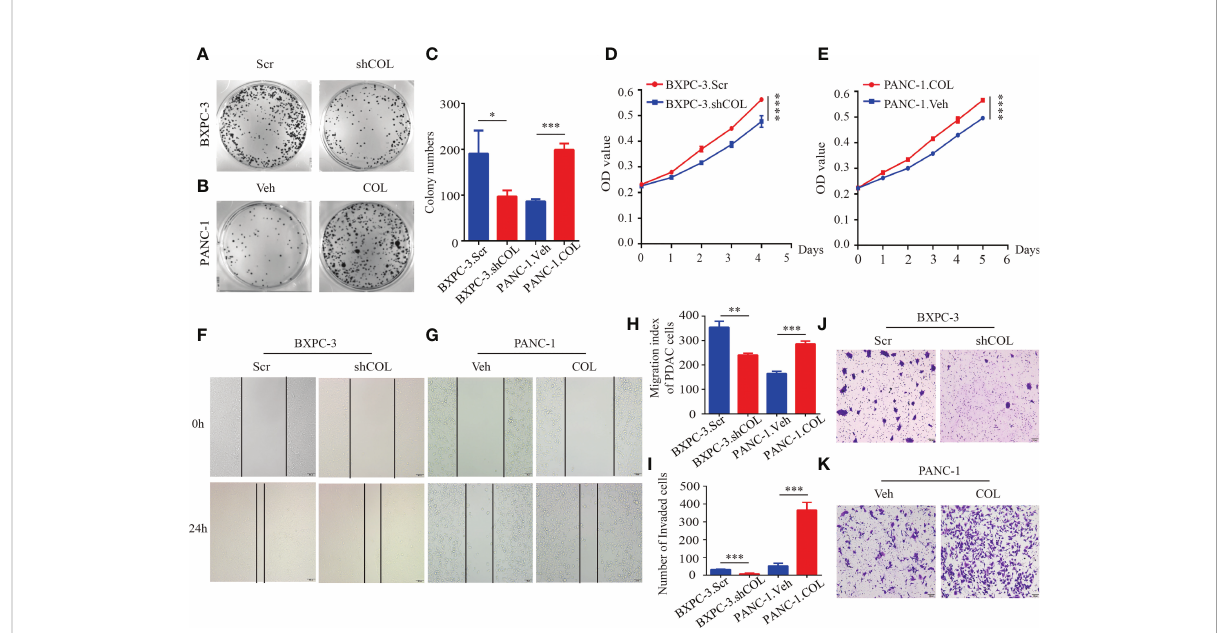
FIGURE 2 COL10A1 promotes PDAC proliferation and migration in vitro . (A-C) Colony formation assays to determine the effect of COL10A1 on the proliferation of PDAC cells. (D, E) Cell proliferation analyses of the PDAC cells. (F-H) Migration ability of cells was tested using wound healing assay. (I-K) Transwell assays detect changes in cell migration after knockdown and overexpression of COL10A1. * P < 0.05, ** P < 0.01, *** P < 0.001, **** P <